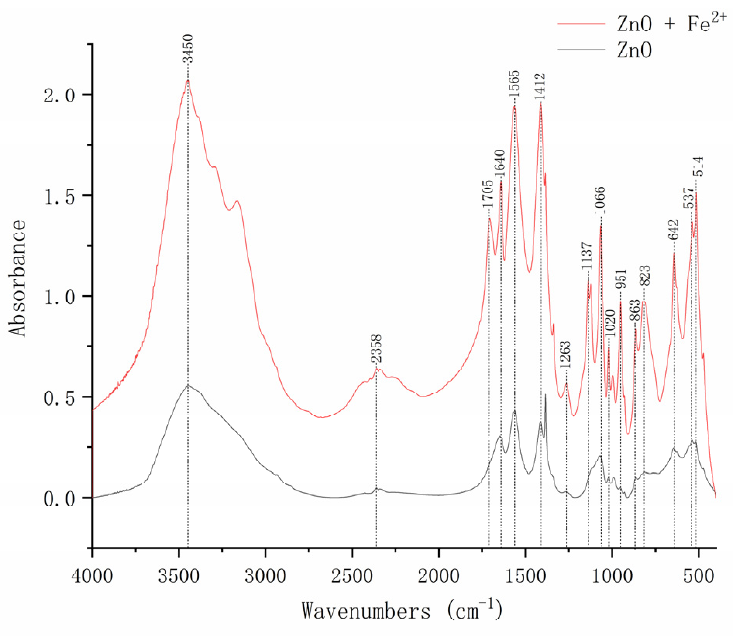
Figure 4. FTIR spectra of 5 mg/L ZnO-NPs with or without Fe 2+ addition. Table 1. Effect of Fe 2+ on the hydrodynamic diameter of